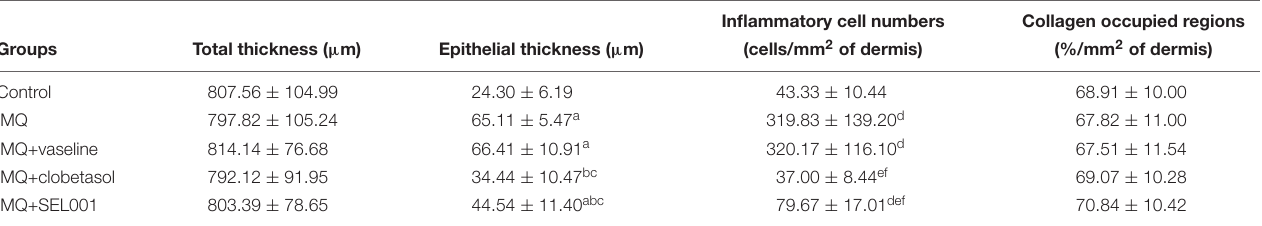
TABLE 2 | Histomorphometrical analysis of dorsal skin tissues taken from control or IMQ-induced psoriasis